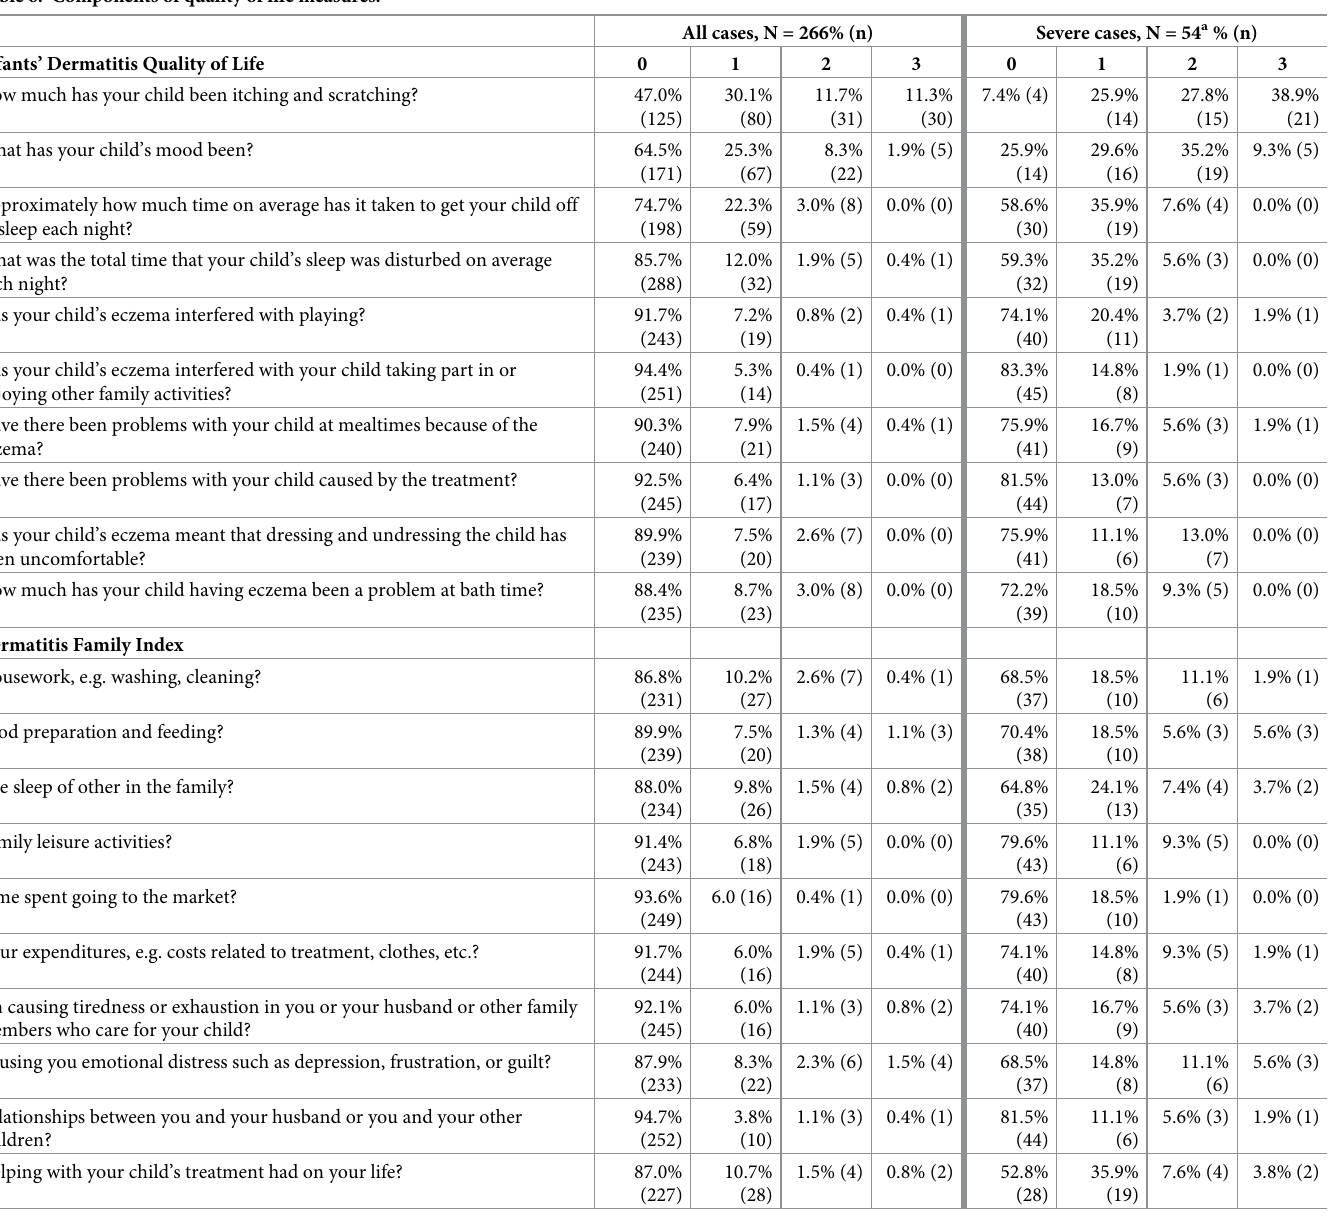
Table 6. Components of quality of life